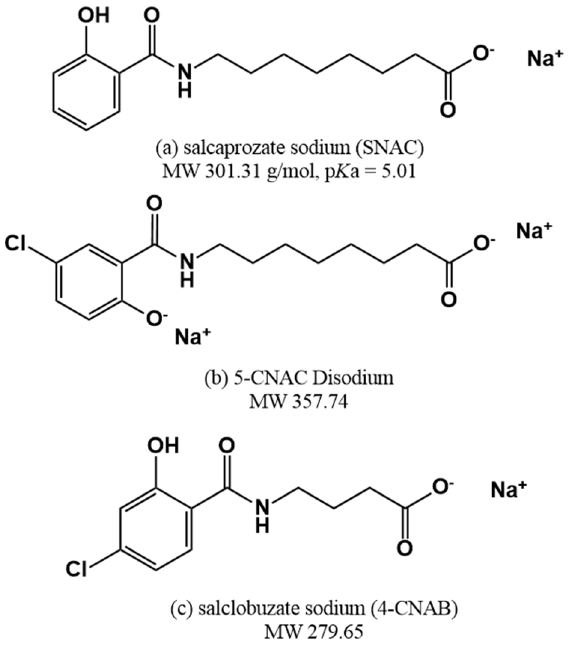
Figure 5. Structures of ( a ) SNAC, ( b ) 5-CNAC, and ( c ) 4-CNAB. SNAC (N-[8-(2-hydroxybenzoyl)amino] caprylate), also called sodium salcaprozate, has a pKa value of 5.01 and a molecular weight of 301.31 Da [128]. It shares structural